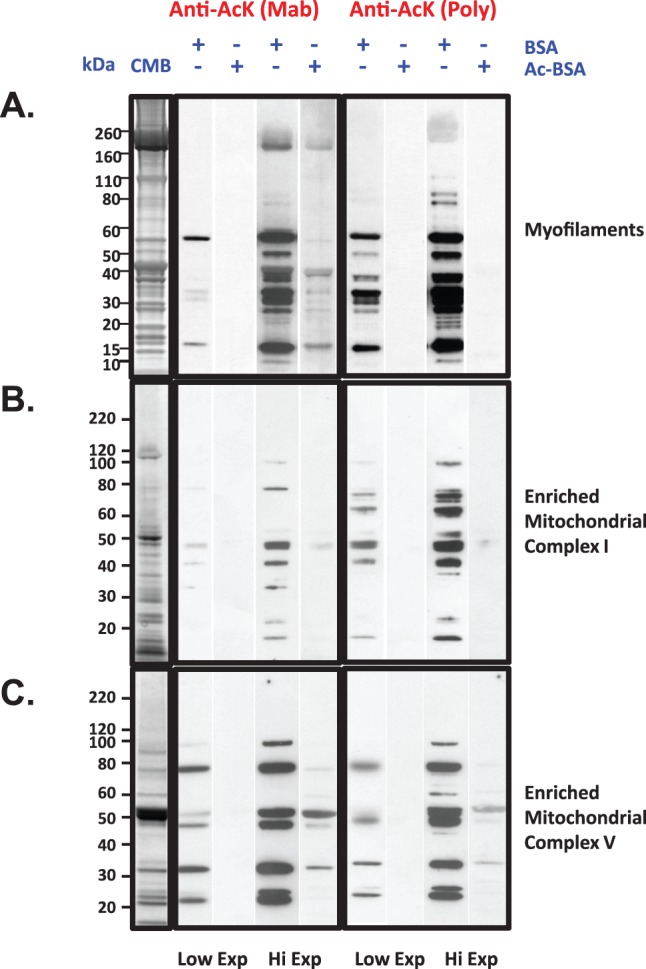
Immunodetection of Cardiac Lysine Acetylation.Panel A. Guinea pig cardiac myofilaments were prepared essentially as described by Solaro et al.
[70]. 30 µg of protein was subjected to electrophoresis and immunoblotting with both monoclonal and polyclonal antibodies to acetylated lysine as described in the Methods section. Lanes with immunoreactive bands are juxtaposed with the corresponding exposure of a parallel control experiment conducted with >2% w/v acetylated BSA in the primary antibody incubation step. Panels B and C. Macromolecular respiratory complexes were resolved as described in the methods. Up to 20 µg of protein from the 30% w/v sucrose fraction (enriched Complex I, Panel B) and the 22.5% w/v sucrose fraction (enriched complex V, Panel C) were probed for immunoreactivity to anti-acetylated lysine as described for Panel A.